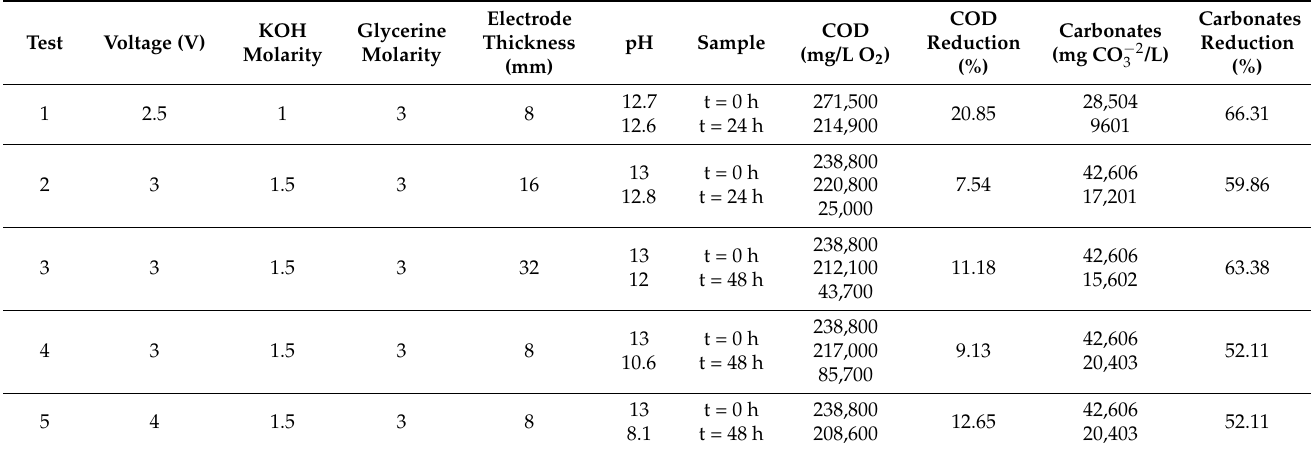
Table 5. COD and carbonate values at the start and end of the alkaline electro-oxidation tests of biodiesel